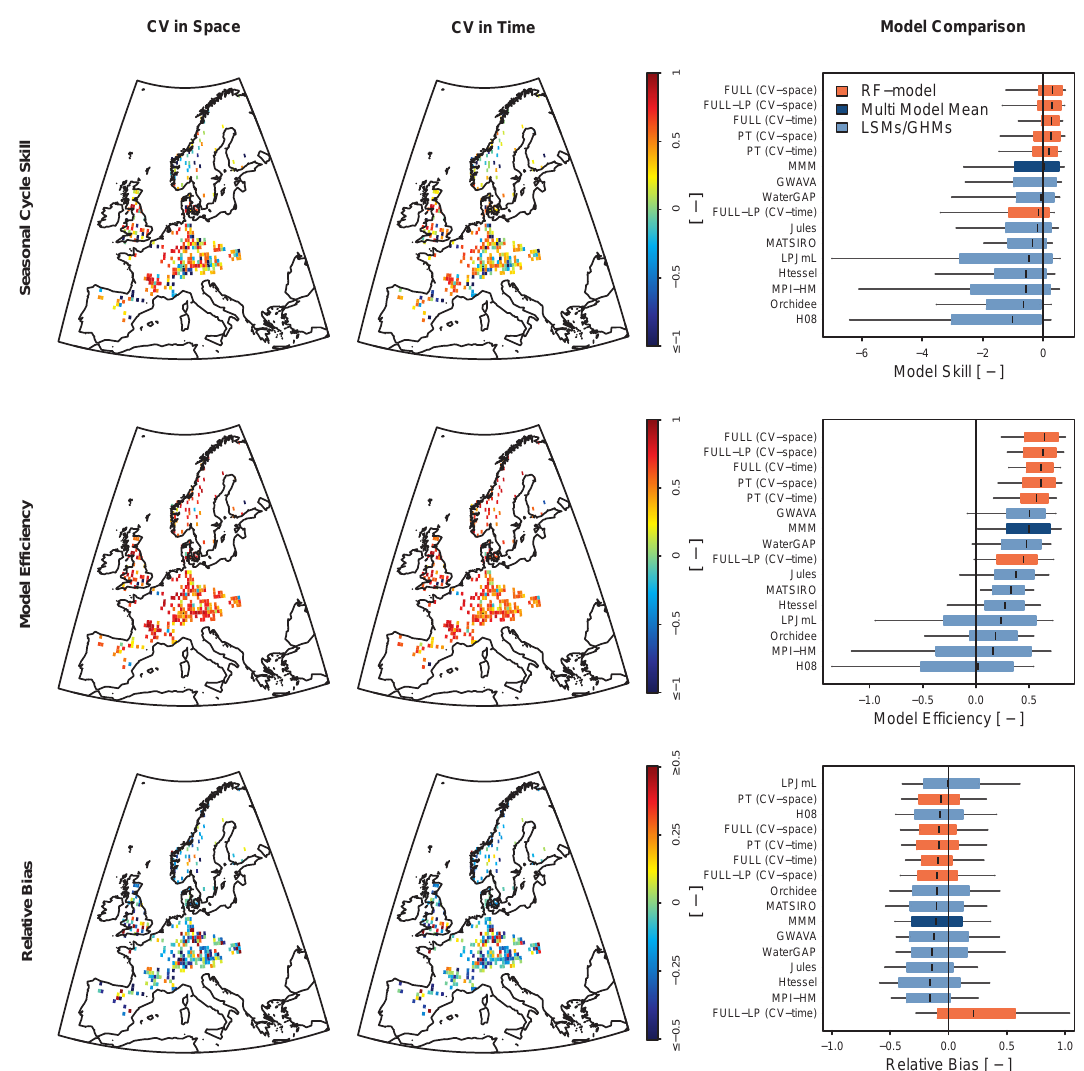
Figure 6. Grid-cell-scale validation (A): spatial distribution of the performance of the random forest model with full atmospheric forcing (Eq. 2), measured with different skill scores and derived for the cross validation (CV) in time and the CV in space experiment. The boxplots allow us to compare the performance distribution of all tested random forest models (Eqs. 1–3) with runoff simulations from a multi-model ensemble of LSMs. The individual boxes are ordered according to the median performance, such that the best performing model ranks